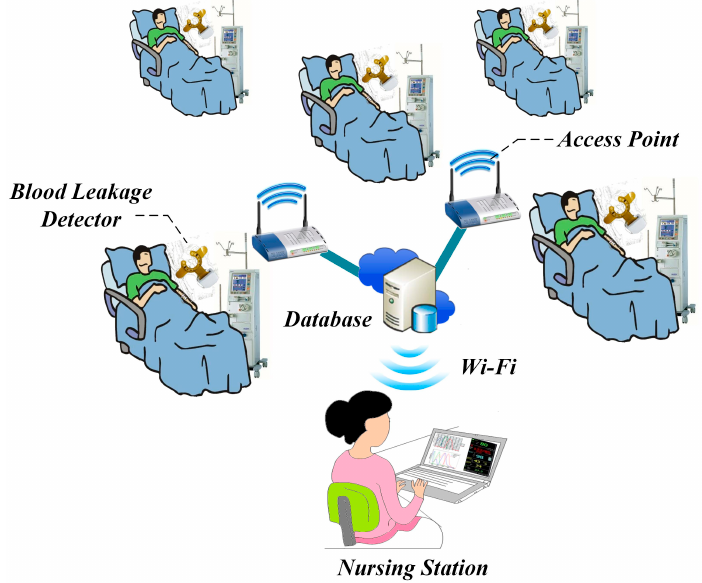
Figure 14. Schematic diagram of multi-bed Wi-Fi monitoring.